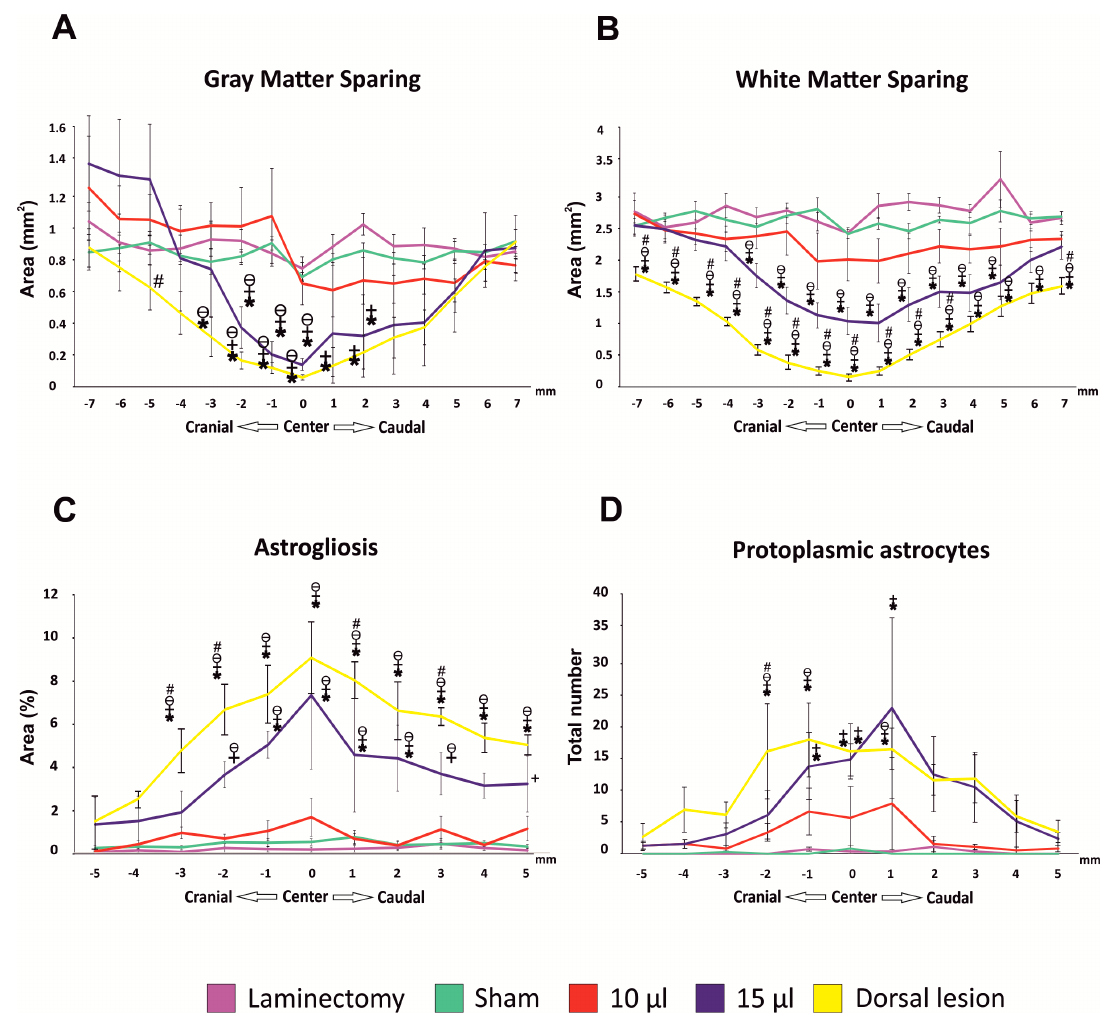
Figure 6. Histological and immunohistochemical assessment. Volumetric measurement of both grey ( A ) and white ( B ) matter revealed significantly decreased total spared areas in both 15 µ L groups (dorsal and ventral). White matter was also significantly decreased in the 10 µ L group. Astrogliosis was observed in the most injured group, and in the center of the lesion covered around 7% of the whole cross section ( C ). Extent of the astrogliosis correlated with the significantly increased number of protoplasmic astrocytes ( D ). For statistical details, see Tables S4–S7 in the Supplementary Material. Data are expressed as mean ± SEM. * p < 0.05 versus laminectomy; + p < 0.05 versus sham; θ p < 0.05 versus 10 µ L; # p < 0.05 versus 15 µ